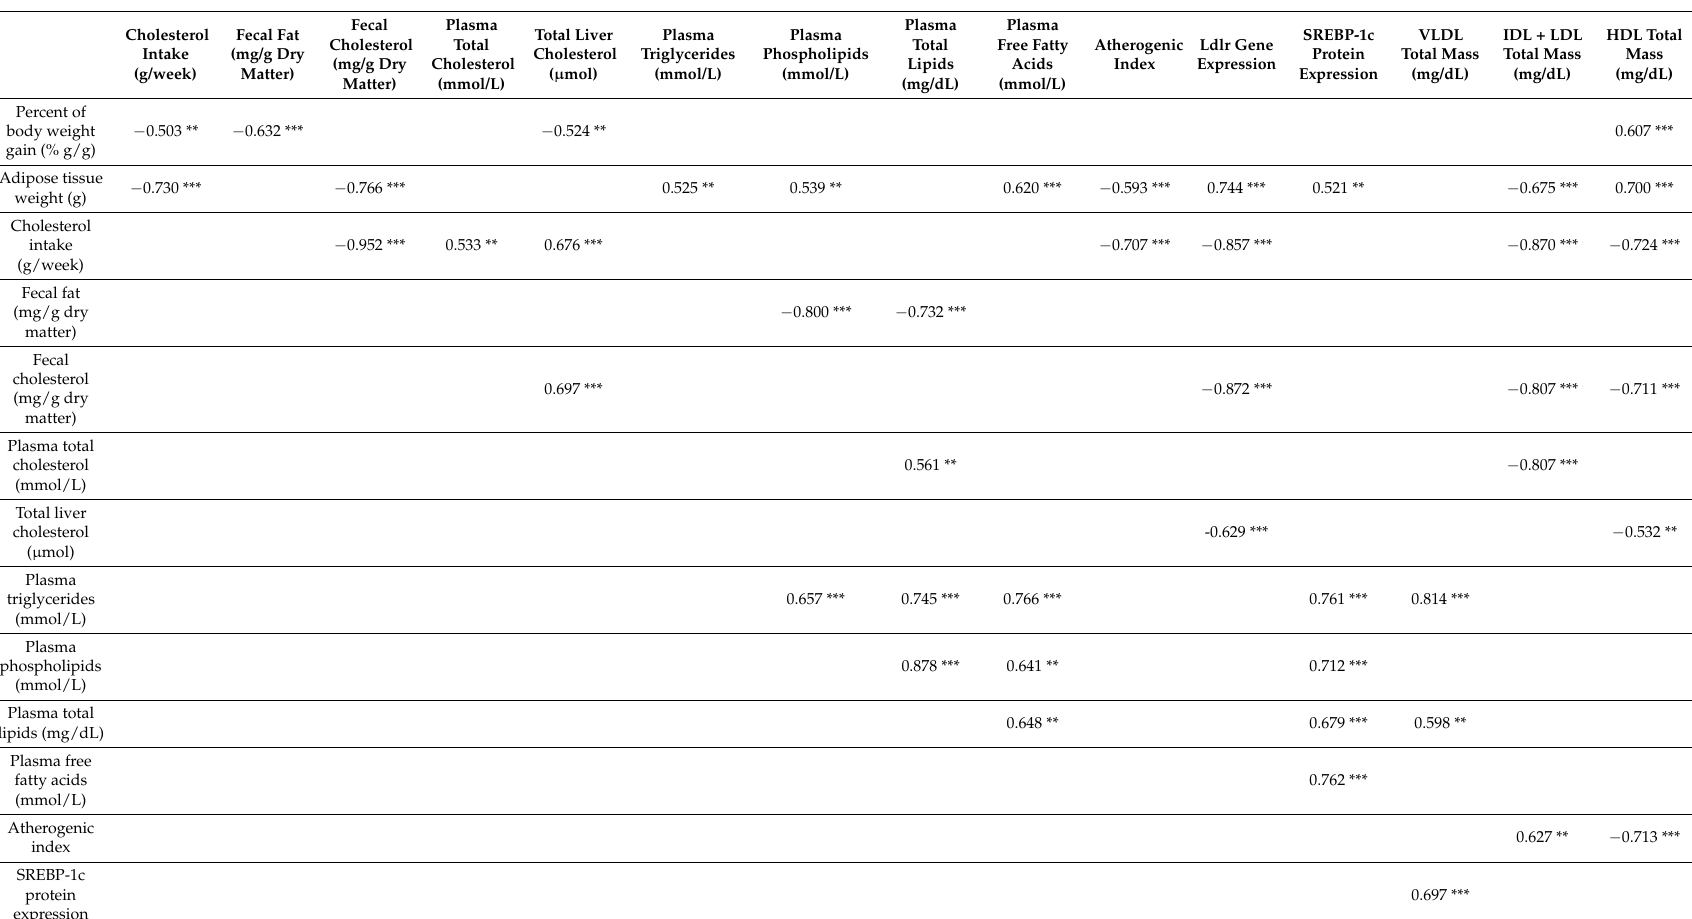
Table 6. Pearson product-moment correlation between